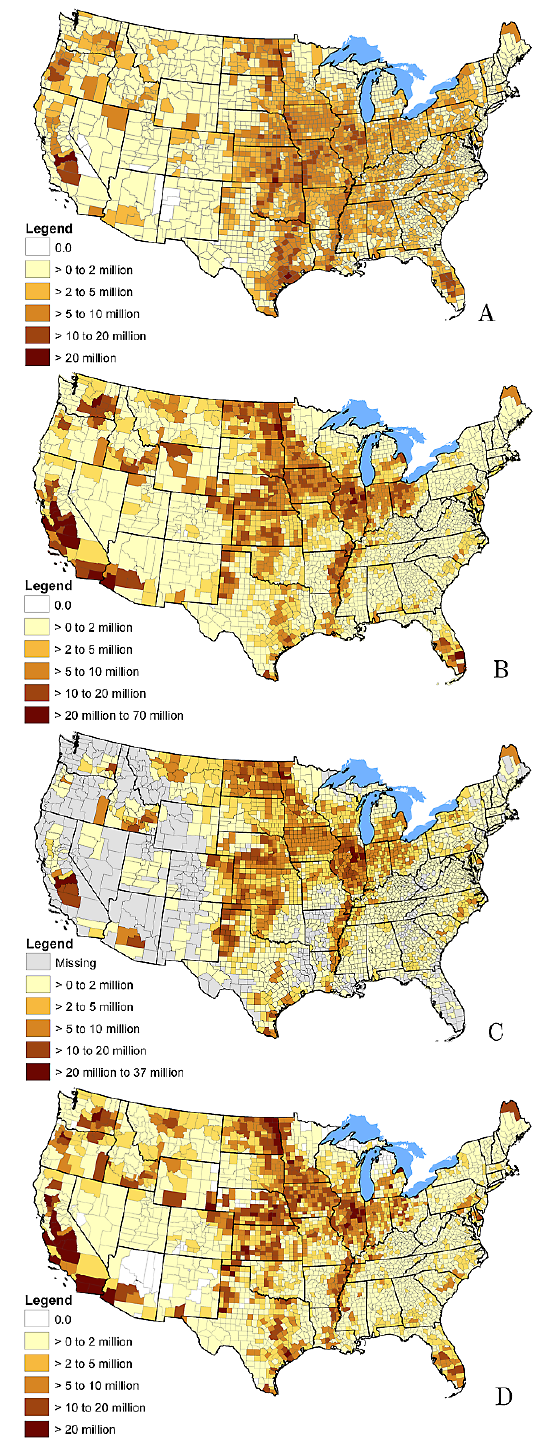
Fig. 5. (A) 5-yraverageannualplantdemand-based(i.e.,EPIC)estimateofinorganic N use, (B) 2001 Inorganic N use Ruddy et al. (2006), (C) survey-based 1997 inorganic N use (NNLSCD; Potter et al., 2006) and (D) 2002 Inorganic N use (activity) as used in the US EPA National Emissions Inventory (Goebes et al., 2003). All values are kg-